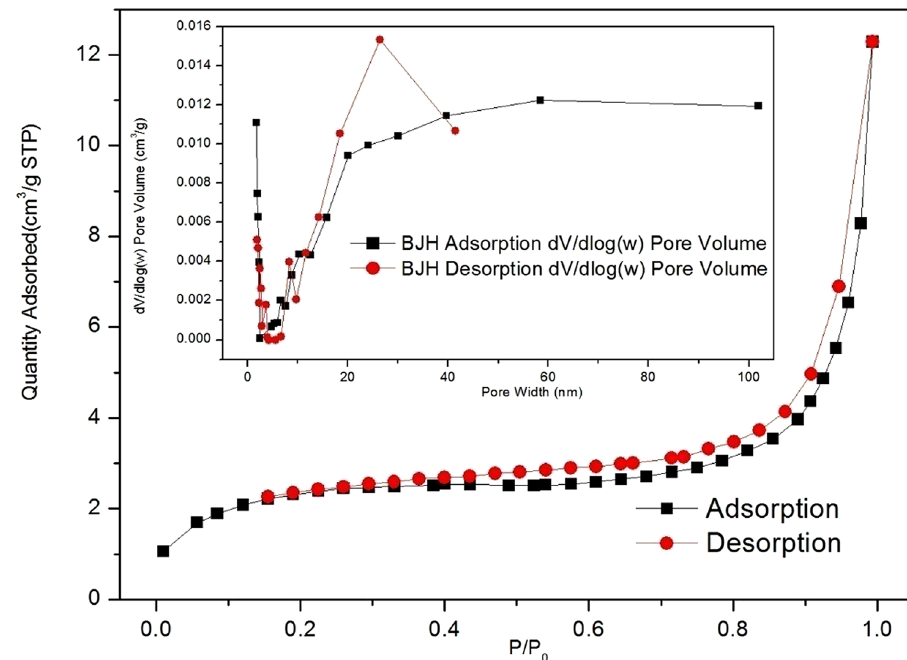
Figure 3: N 2 adsorption – desorption isotherms of the Sm - MOF.